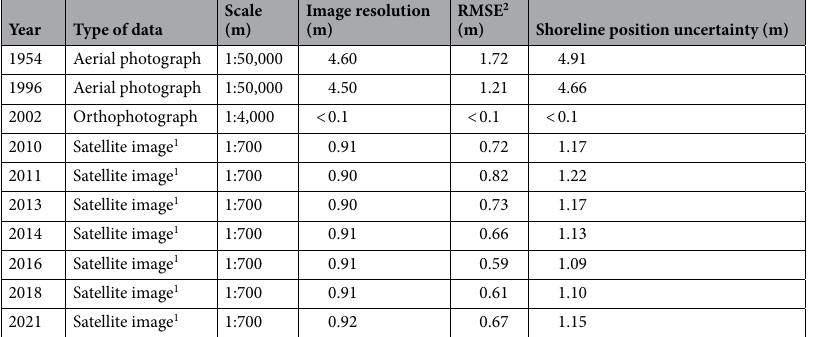
Table 3. Summary of the data used for assessing the shoreline change along the eastern Chao Phraya Delta coastline. 1 Download in JPG format at no cost from Google Earth Pro software version 7.3 (https:// www. google. com/ earth). 2 RMSE = Root Mean Square Error from georeferencing